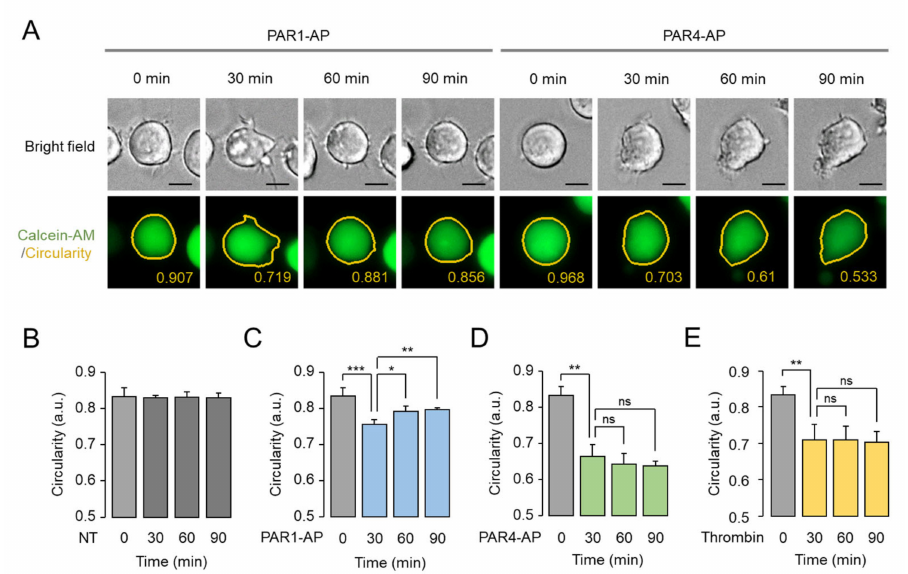
Figure 5. Time-course assessment of PAR1- and PAR4-mediated morphological changes. ( A ) Rep- resentative time-lapse images of MEG-01 cells. Cells were stained with calcein-AM (1 µ g/mL) and treated with PAR1-AP (100 µ M) and PAR4-AP (100 µ M). Images were automatically captured by Lionheart every 30 min. Scale bar = 10 µ m. ( B – E ) Summary of circularity. Cells were applied with PAR1-AP, PAR4-AP, and 0.1 U/mL of thrombin, and circularity was measured in time-course using Lionheart software (mean ± S.D., n = 4). * p < 0.05, ** p < 0.01, *** p < 0.001, ns: not